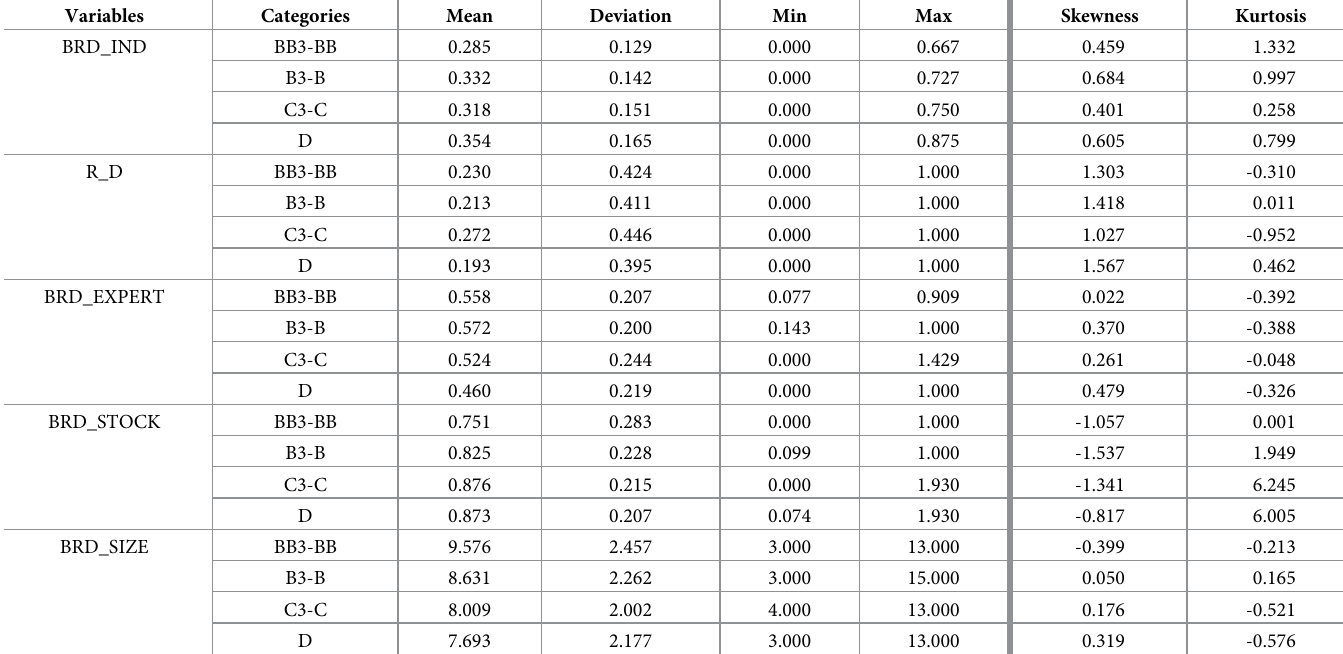
Table 2. Descriptive statistical